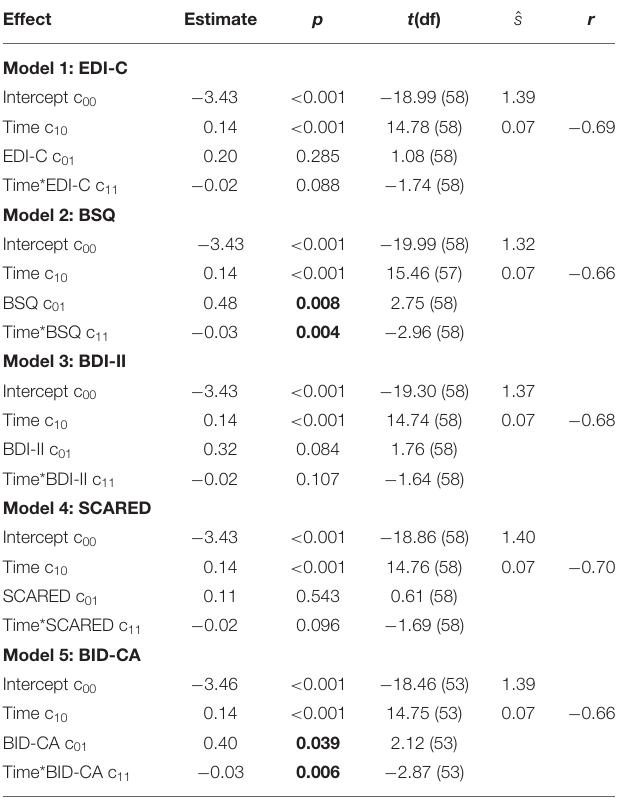
TABLE 4 | Random-intercept-random-slope-model: level-2-predictors and BMI. Effect